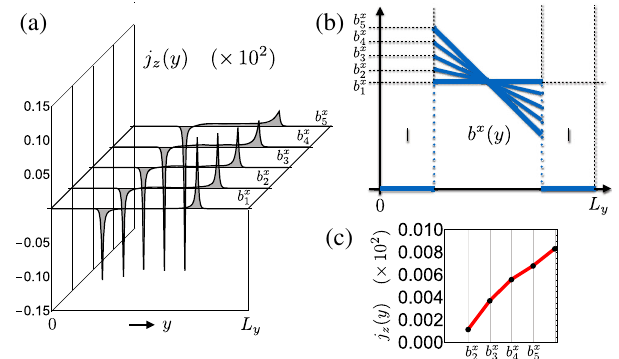
FIG. 6. Bound current density in an inhomogeneous Weyl semimetal. Panel (a) shows the five different current densities j y Þ corresponding to the five different profiles of the axial- z ð vector potential shown in (b), labeled b x with a ¼ 1 , 2, 3, 4, 5. a Larger values of a support larger axial magnetic fields B ∇ × b , which create bulk pseudo-Landau levels [see 5 ¼ Fig. 7(c)] that compensate for the missing current density at the boundary. Plot (c) shows the bound current density at a point y ¼ L = 2 belonging to the Weyl semimetal bulk for different y values of b x a